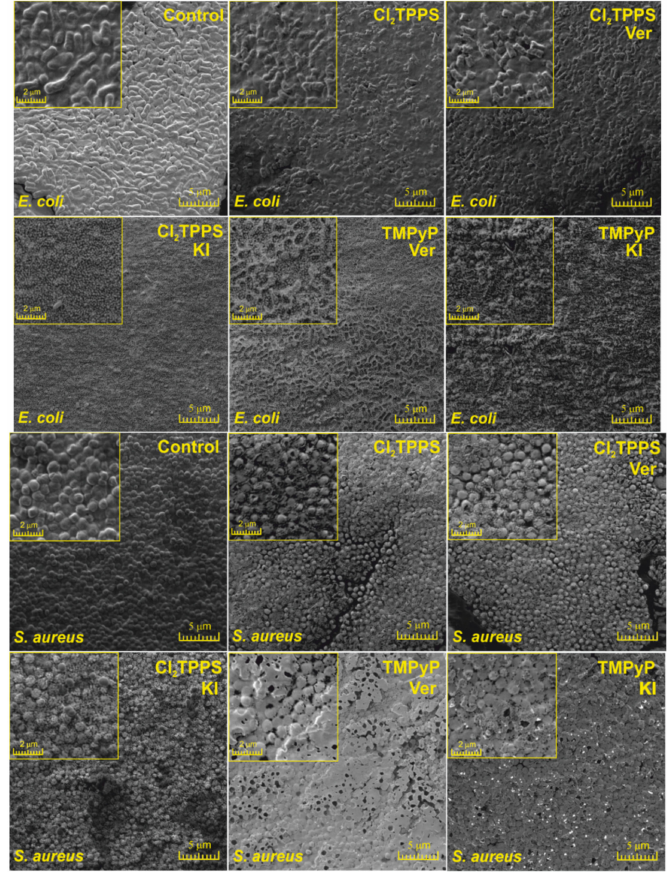
Figure 18. Scanning electron microscopy images of the control and after the PDI-treated bacteria E . coli (upper part) and S. aureus (lower part) with and without the addition of verapamil (Ver) and potassium iodide (KI) at a 10 J / cm 2 light